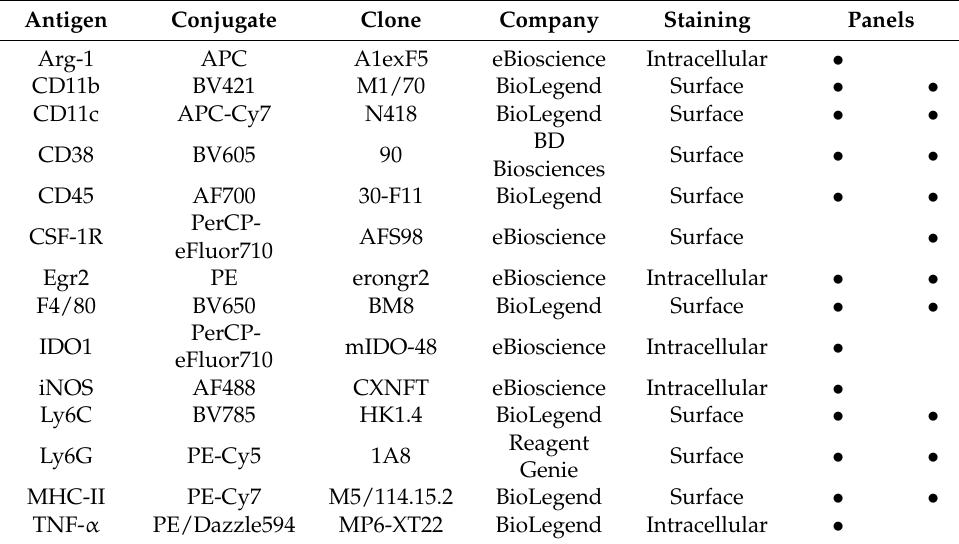
Table 1. List of antibodies used for flow